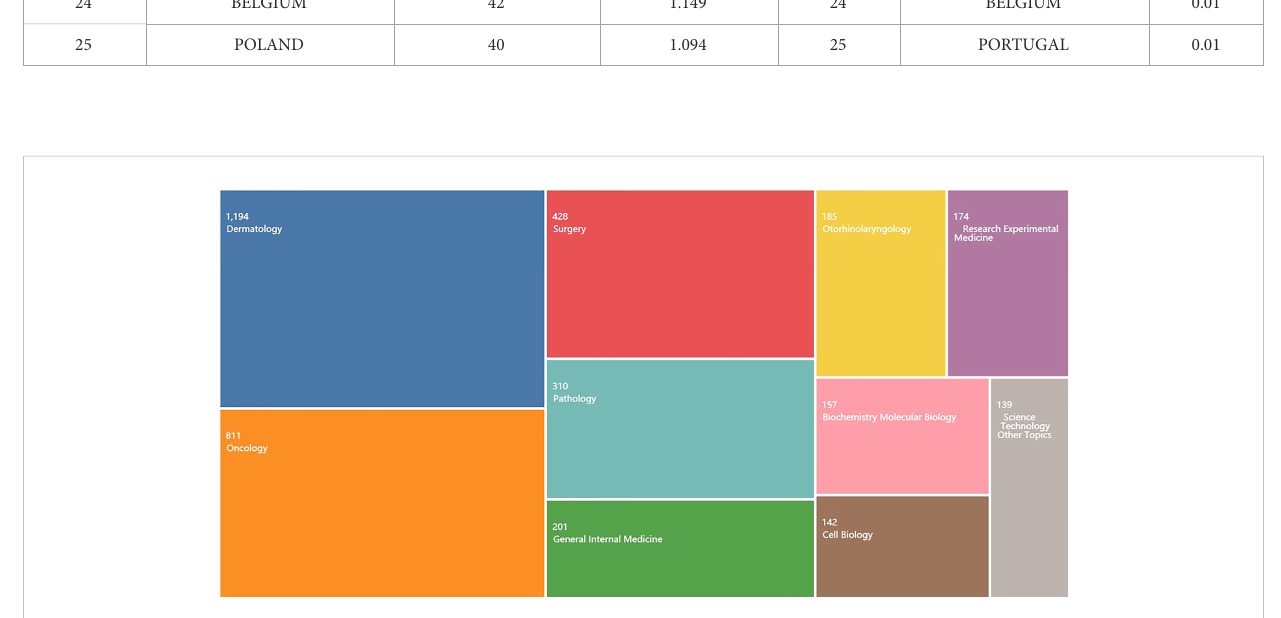
FIGURE 3 Analysis of research